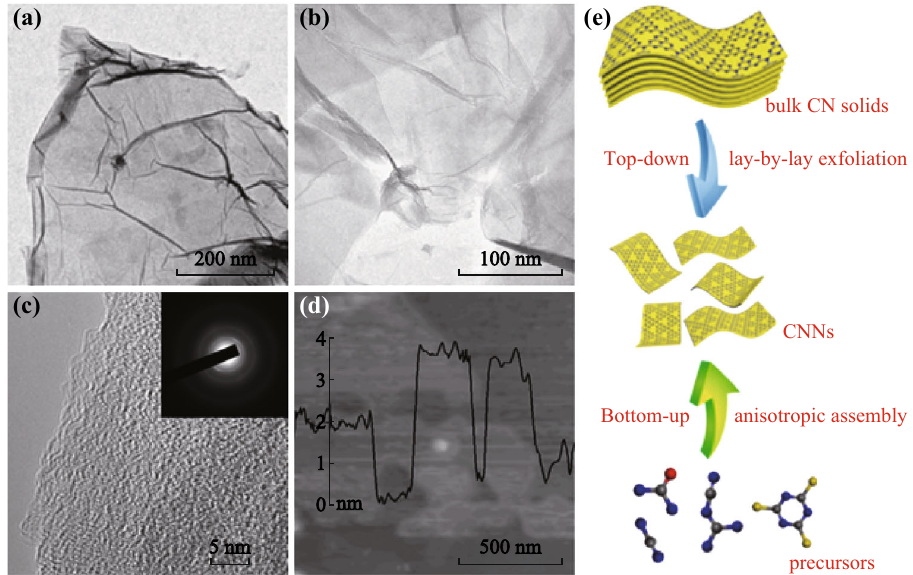
Fig. 4 a-c TEM images and d AFM image of g-C 3 N 4 nanosheets. Inset of c SAED pattern. Reprinted with permission from Ref. [52]. Copyright 2014 John Wiley and Sons. e Schematic illustration of top-down and bottom-up synthetic strategies for g-C 3 N 4 nanosheets. Reprinted with permission from Ref. [68]. Copyright 2015 The Royal Society of Chemistry. (Color figure online) semiconductor quantum dots (QDs) (for example, Se in CdSe, Pb in PbTe, and Te in CdTe) all have risks of long- term toxicity and potential environmental hazards. Similar